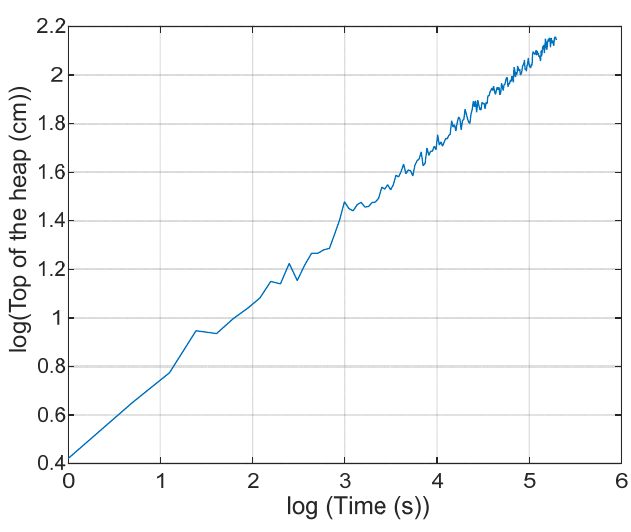
Figure 3. Function 𝑙𝑜𝑔(cid:4670)ℎ(cid:4666)log (cid:4666)𝑡(cid:4667)(cid:4667)(cid:4671). Figure 3. Function log [ h ( log ( t ))] .